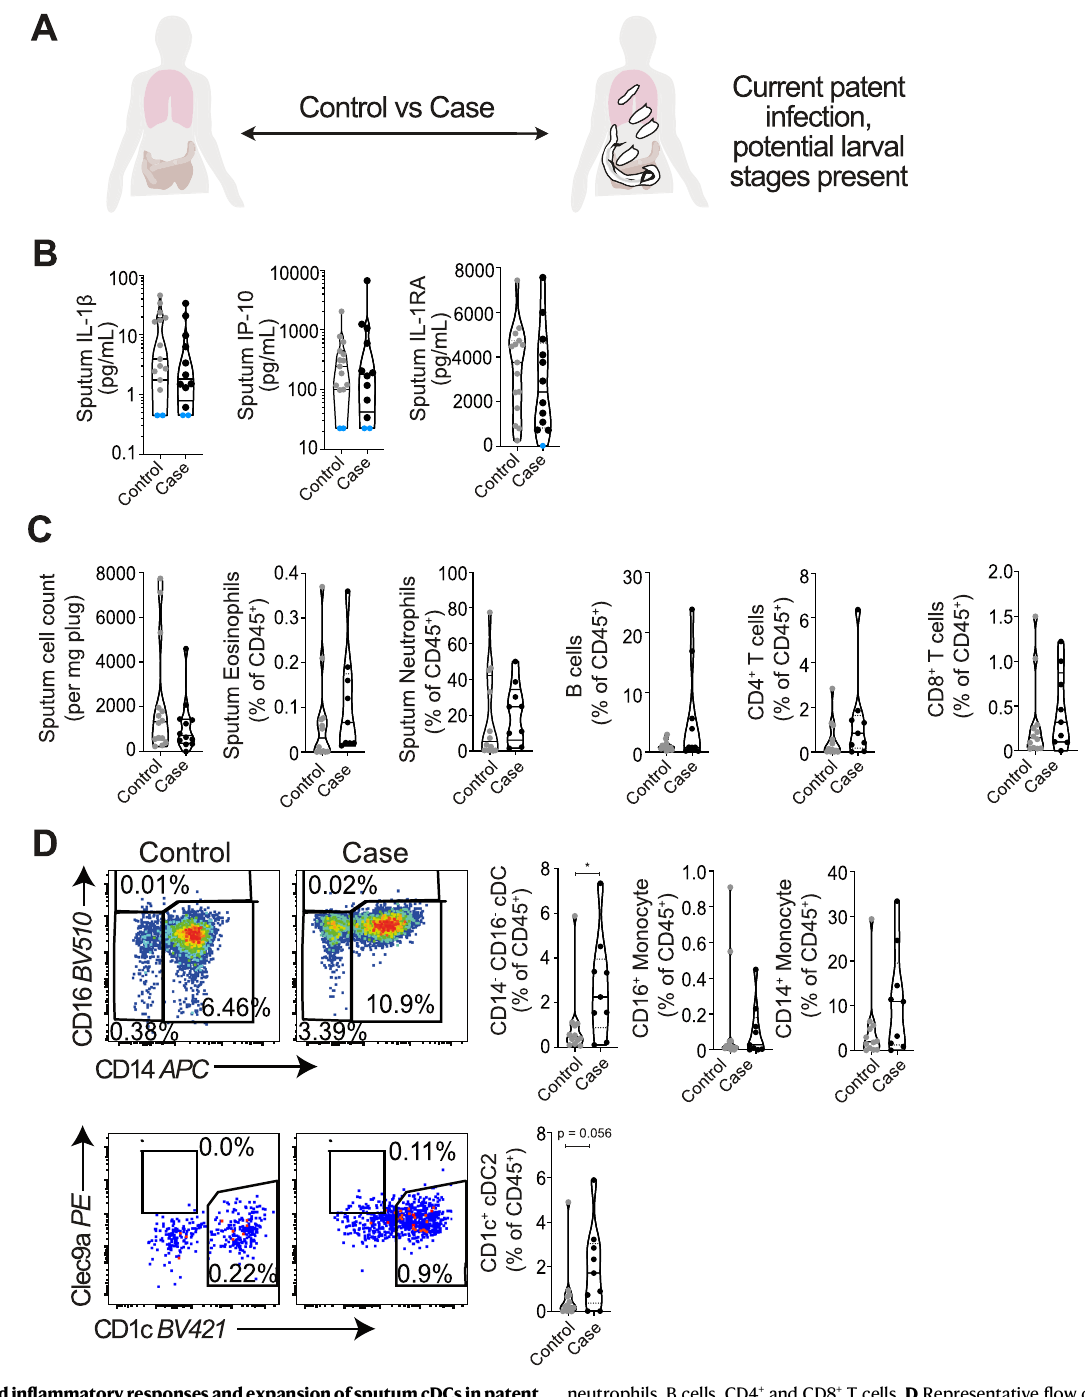
neutrophils, B cells, CD4 + and CD8 + T cells. D Representative fl ow cytometry plots show alterations in monocytes (HLA-DR + , CD14 + or CD16 + ), cDCs (HLA-DR + , CD14 − CD16 - ),and cDCsubsets(cD1c + )ininfectedindividuals.Gatefrequenciesshow%of CD45 + cells.Dataarefromonestudy( n =21individuals).Two-sidedMann – Whitney tests were used to compare differences between groups. * p <0.05. Data are pre- sented as mean values ± SEM. Source data are provided as a Source Data fi